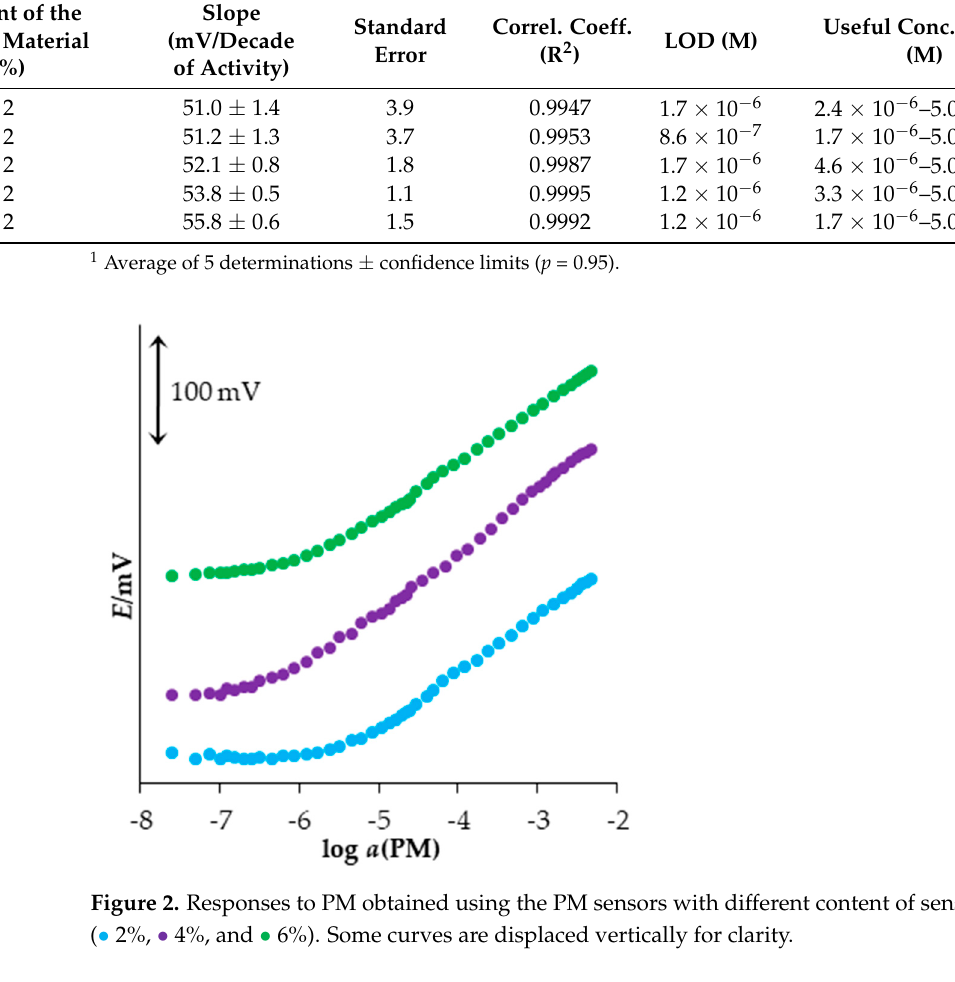
Table 2. Statistics of the response characteristics of the PM sensors with different plasticizers, to PM 1 . Plasticizer